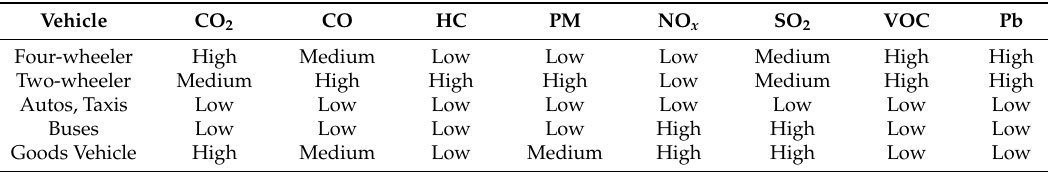
Table 1. Emissions from transport sector in New